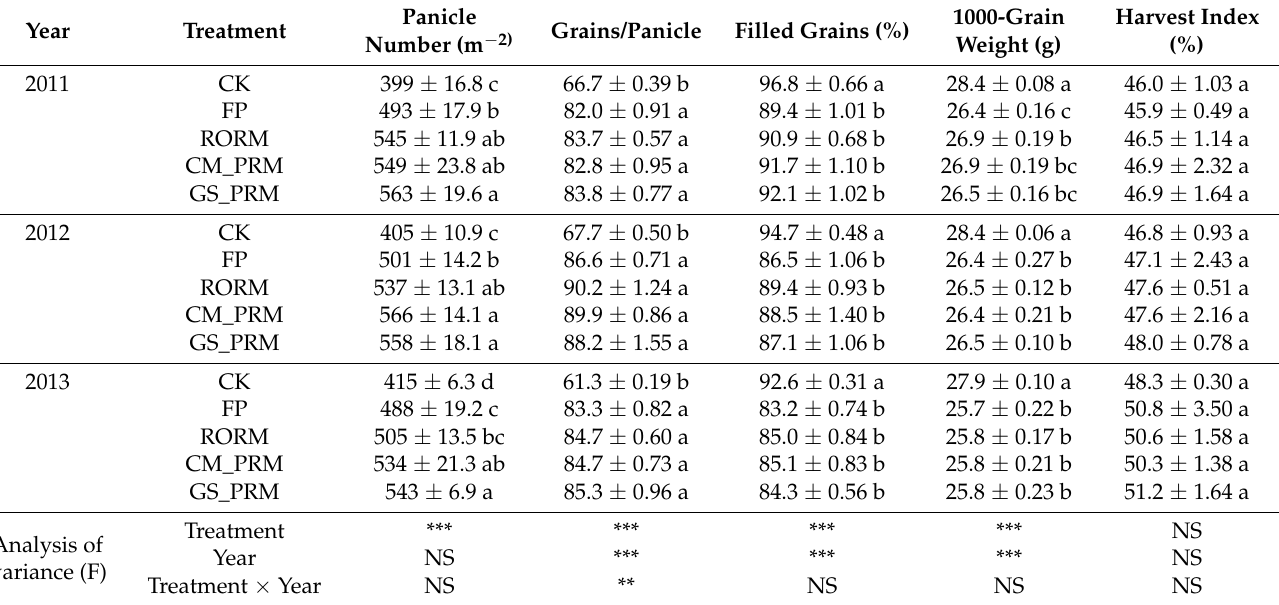
Table 2. Average values ± standard deviations of grain yield components obtained in different rice management systems with rice variety Longjing 21 from